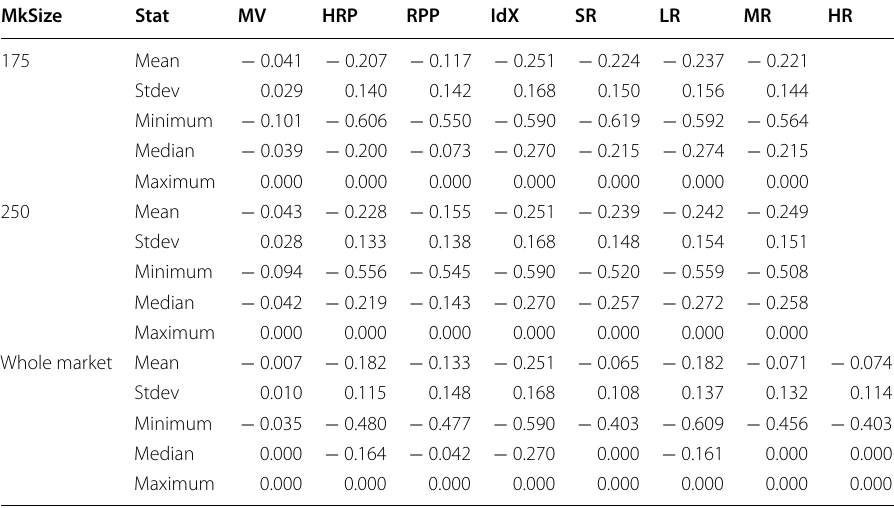
Table 7 Conditional VaR (CVaR or ETL) of the simulations (1500 random investing paths) for the different strategies MkSize